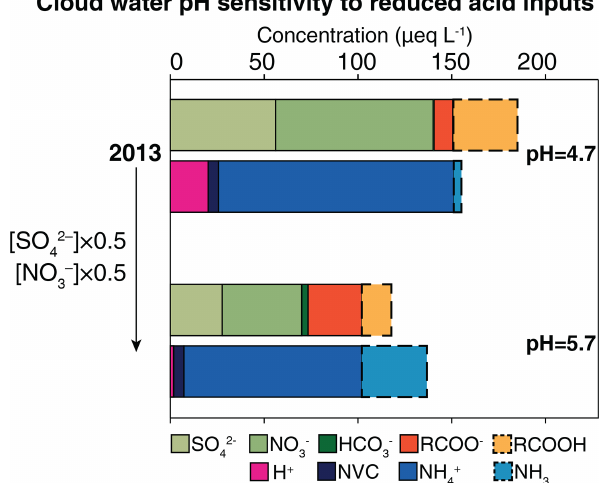
Figure 5. Sensitivity of cloud water pH to decreasing acid inputs over the contiguous US. The upper bars show the volume-weighted average concentrations of acidic and basic ions for 2013, with ad- ditional dashed lines showing the undissociated concentrations of carboxylic acids (RCOOH) and the gas-phase concentration of am- monia (NH 3 ). The lower bars show the effect of decreasing [SO 2 − and [NO − ] by half relative to 2013 levels. All concentrations are 3 expressed as cloud water equivalents. The corresponding pH values are